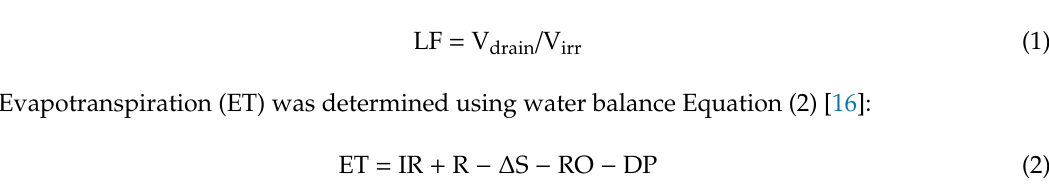
Table 1. Chemical properties of irrigation water used for the experiment: tap water (control), brackish groundwater (BGW) from BGNDRF, RO concentrate (RO) from BGNDRF, and BGW + NaCl irrigation. Ion Concentration meq L − 1 mg L − 1 Treatment Na + Ca + Mg 2 + K + Cl − SAR EC (dSm − 1 ) pH Control (tap water) 2.53 2.59 BGW RO (Ca + dominant) BGW + NaCl (Na + dominant) EC: electrical conductivity, SAR: sodium absorption